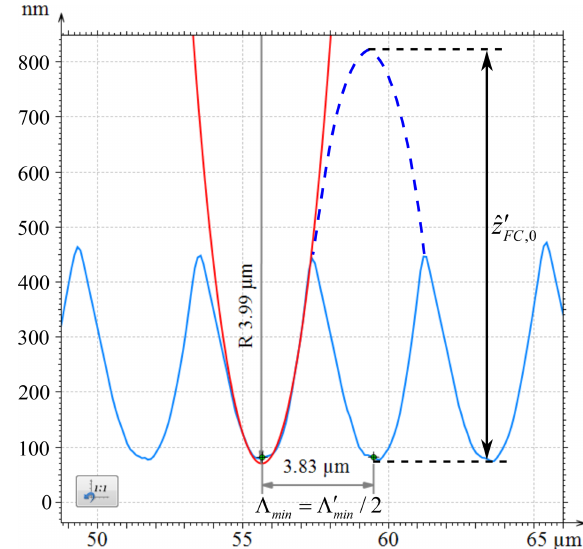
Figure 7. Section of the chirp profile with the shortest spatial wave- length measured by the AFM (blue line) and a fitted concentric cir- cle (red line) with a radius of 3.99µm, using the software Moun- tainsMap. The additional blue dashed line illustrates a sine with the spatial wavelength (cid:51) (cid:48) and the amplitude ˆ z (cid:48) min FC , 0